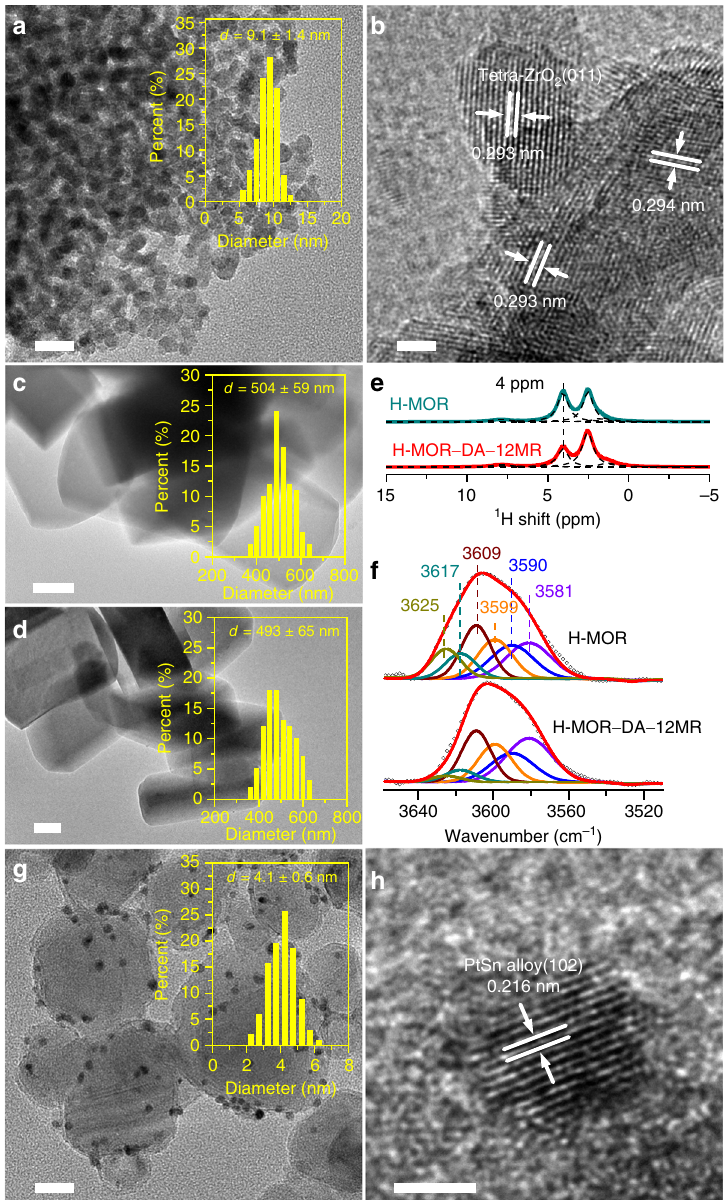
Fig. 3 Characterization of tandem catalysts. a TEM micrograph for K + – ZnO – ZrO 2 particles with particle size distribution. Scale bar: 20 nm. b HRTEM micrograph for K + – ZnO – ZrO 2 particles. Scale bar: 2 nm. c TEM micrograph for H-MOR with particle size distribution. Scale bar: 100 nm. d TEM micrograph for H-MOR – DA – 12MR with particle size distribution. Scale bar: 100 nm. e 1 H MAS NMR for H-MOR and H-MOR – DA – 12MR zeolites. The peak at 4.0 ppm can be attributed to the Brønsted acid site. f FT-IR spectra of H-MOR and H-MOR – DA – 12MR zeolites. Assignments of deconvoluted bands: 3625, 3617 and 3609 cm − 1 : Brønsted acid sites in 12-MR; 3599 cm − 1 : Brønsted acid sites in intersections between 8-MR and 12-MR; 3590 and 3581 cm − 1 : Brønsted acid sites in 8-MR. g TEM micrograph for Pt – Sn/SiC with particle size distribution. Scale bar: 20 nm. h HRTEM micrograph for a Pt – Sn particle. Scale bar: 2